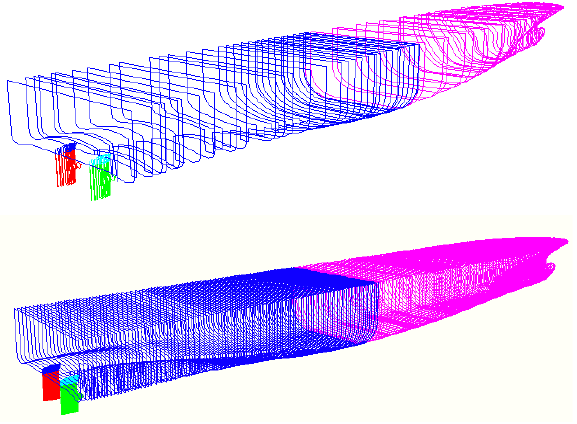
Figure 6. Two models of the EMSA2